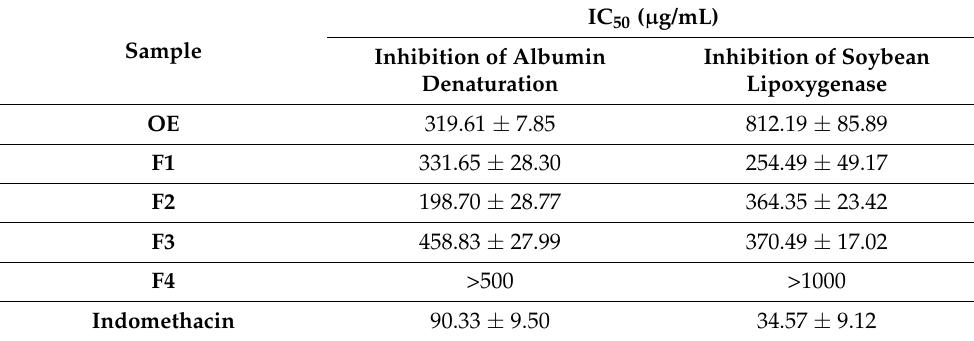
Table 5. IC 50 values of albumin denaturation and soybean lipoxygenase activity of OE and F1 – F4 obtained from E. cavolini . Indomethacin was used as positive